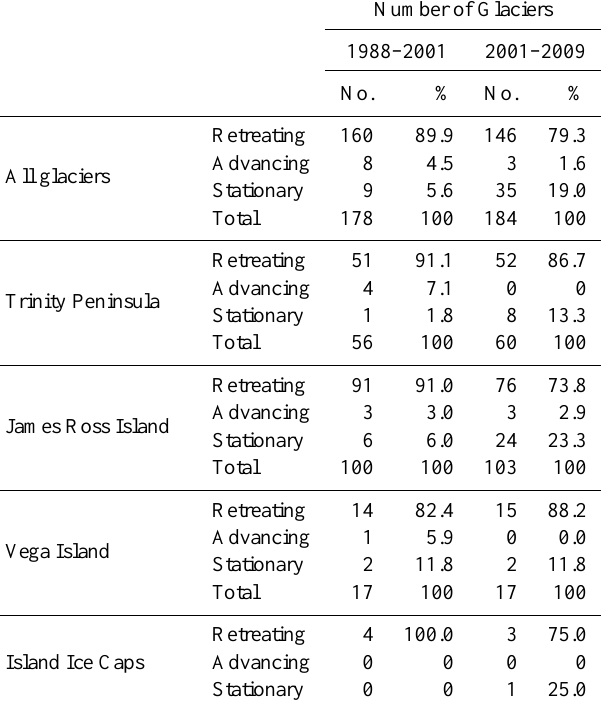
Table 7. Number of glaciers advancing and retreating in the period 1988 to 2009. Note that missing data means not all 194 glaciers were